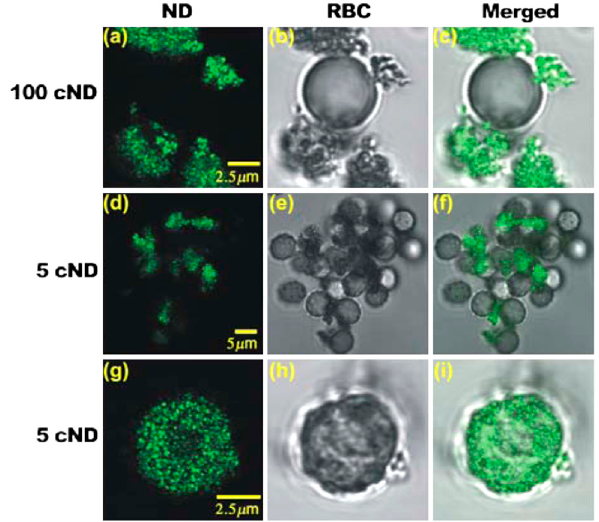
Figure 4. Nanodiamond interaction with human RBCs. Fluorescence ( a , d , g ), bright field ( b , e , h ) and merged optical microscopy images ( c , f , i ) of 100 nm ( a – c ) and 5 nm ( d – i ) nanodiamond particles. The images show larger NDs (100 nm) attaching to the cell membrane and smaller NDs (5 nm) penetrating inside the erythrocytes. Reproduced with permission from [86].